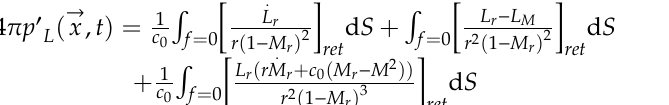
( a ) Unstable point ( b ) Transition point Figure 3. The Granville method to determine the unstable point and the transition point. 3. Calculation of the flow noise power spectrum